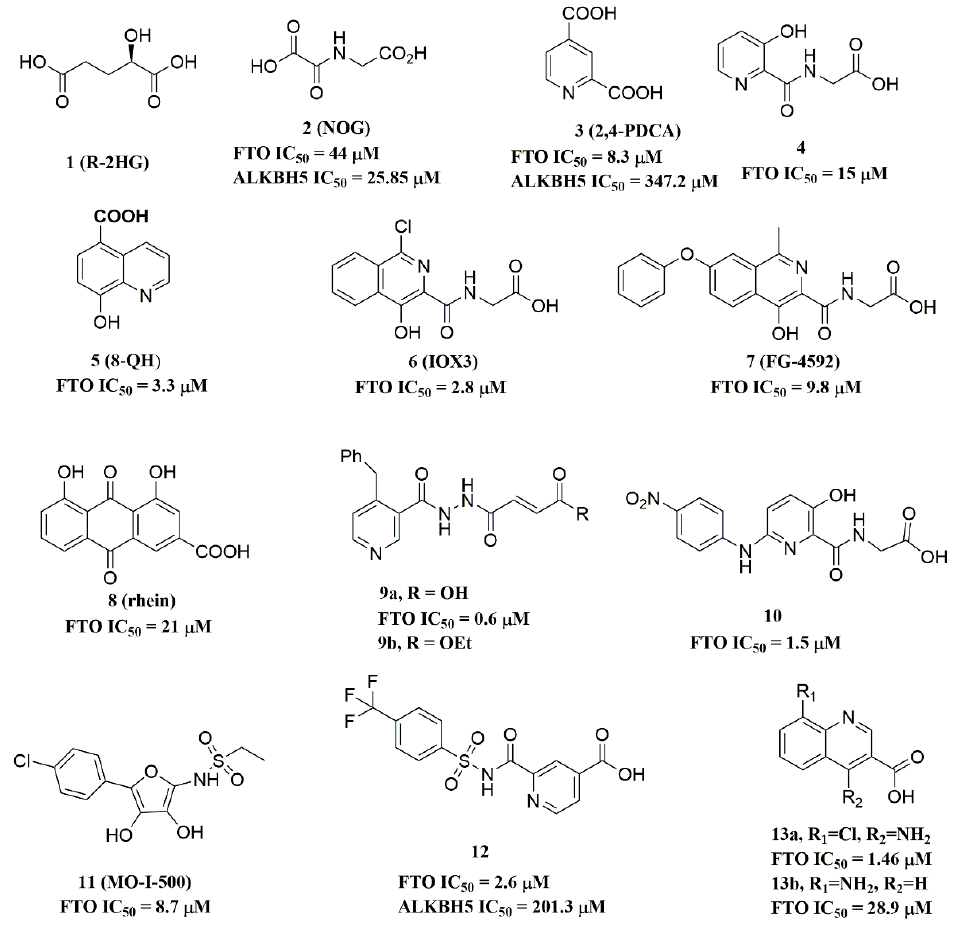
Figure 3. Metal-chelating inhibitors of FTO.